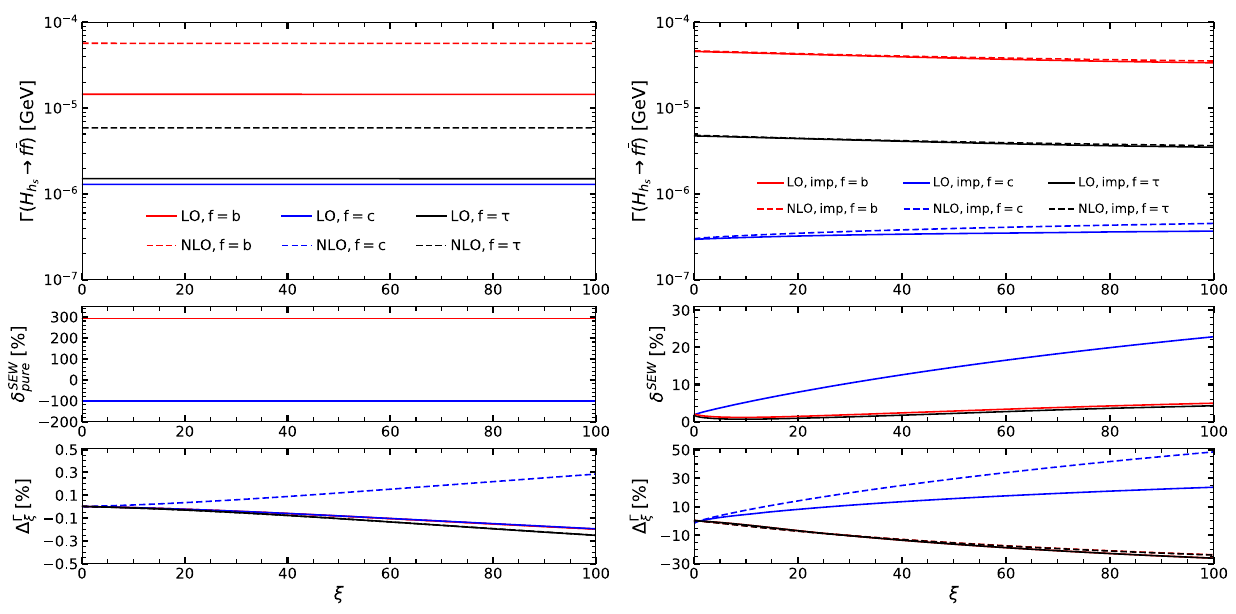
Fig. 16 Left plots: pure LO and NLO widths computed using Eqs. (5.27) and (5.28). Right plots: LO and NLO improved widths computed using the Z H matrix and the loop-corrected masses as done in Eqs. (4.13) and (4.14). Top Panel: The CP-even singlet-like Higgs boson decay width into b ¯ b (red), c ¯ c (blue), τ ¯ τ (black) as a function of the gauge parameter ξ at tree level (solid lines) and pure NLO level (dashed lines). The dashed blue line on the upper left plot is not shown since the width is negative and close to zero, about − 2 . 4 × 10 − 9 GeV.